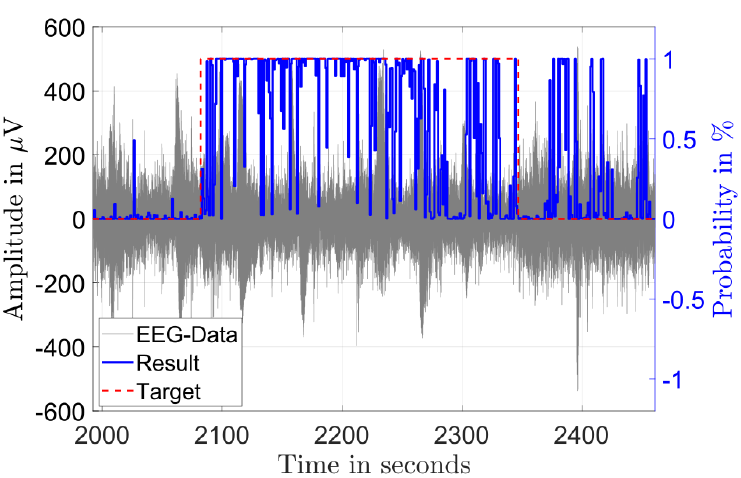
Figure 4. Single channel EEG data (gray) from a seizure record file of patient 8 showing 264 s of diagnosed seizure (red) and the output probability of the classification